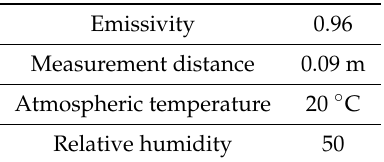
Table 2. Infrared camera